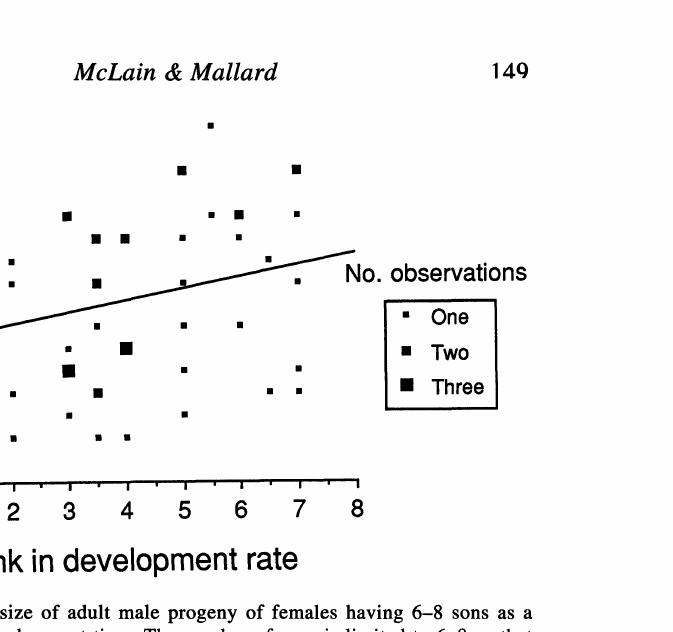
Figure 6. Rank in size of adult male progeny of females having 6-8 sons as a functon of rank in development time. The number of sons is limited to 6-8 so that artifactual correspondence of high ranks is not introduced by the inclusion of females with few